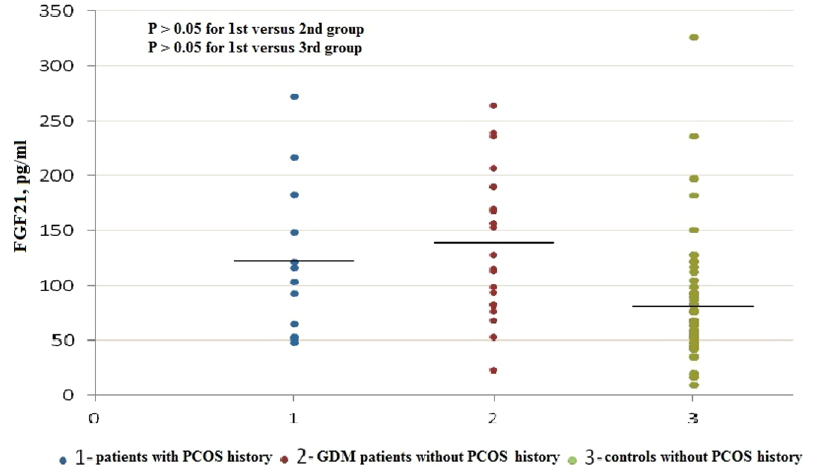
Figure 2. Scattergram of serum FGF21 levels in patients with PCOS history, GDM patients without PCOS history. Horizontal lines across the scatter diagram represent median values. Differences between groups were assessed by Mann-Whitney U test with Bonferroni adjustment for multiple testing.